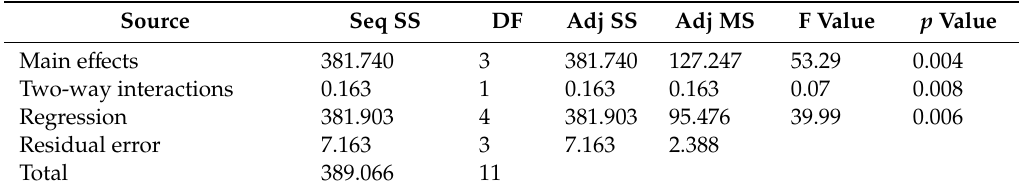
Table 5. ANOVA for desorption of